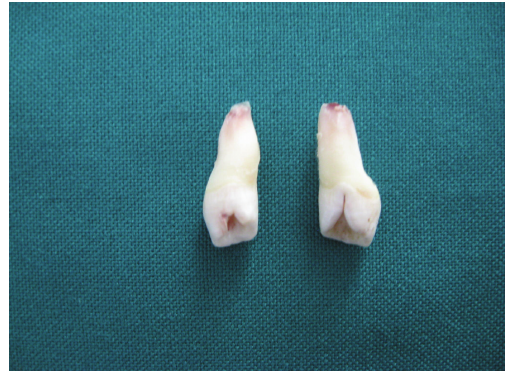
Figure 4: Lingual aspect of both mesiodens showing the dens